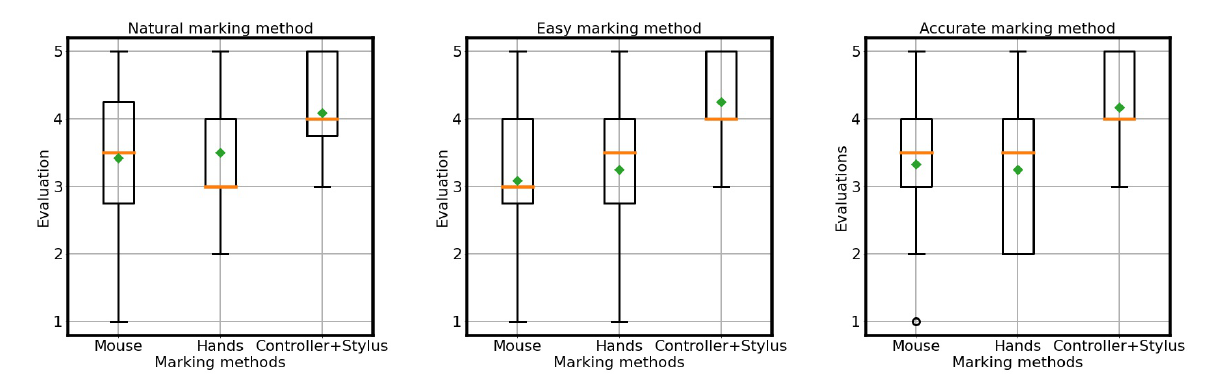
Figure 6. Box plot visualizations of the interaction method evaluations. The evaluation of interaction method naturalness ( left ), easiness ( middle ), and accuracy ( right ). Controller+stylus was the most liked method in these features. There were significant differences between controller+stylus and hands in all attributes (naturalness, easiness, and accuracy) and between controller+stylus and mouse in naturalness and easiness.